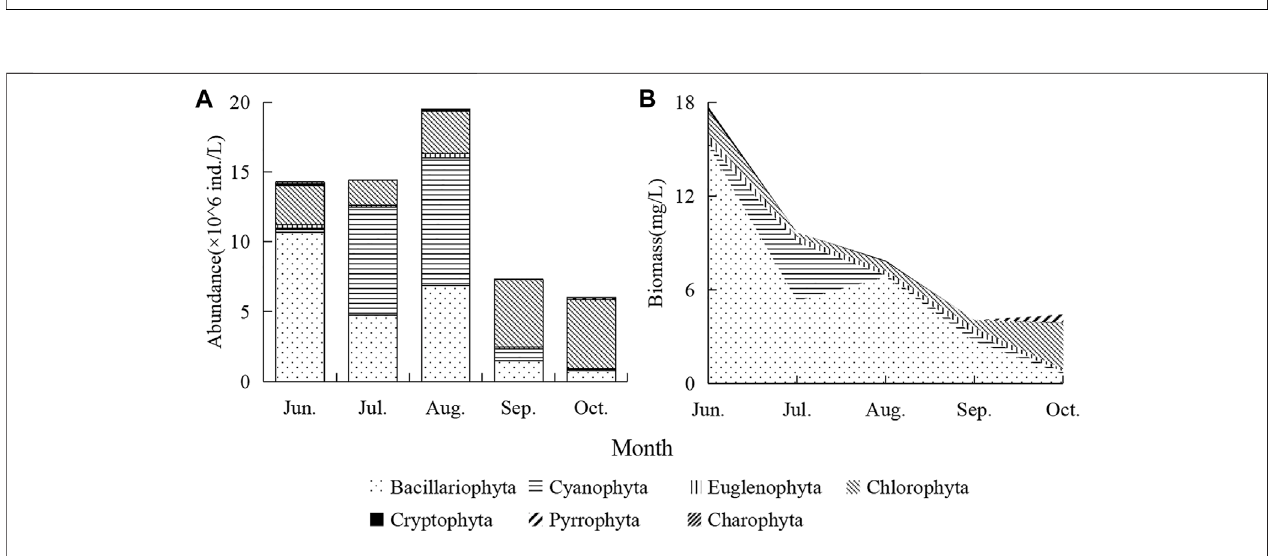
FIGURE 4 | Temporal changes of phytoplankton abundance (A) and biomass (B) .